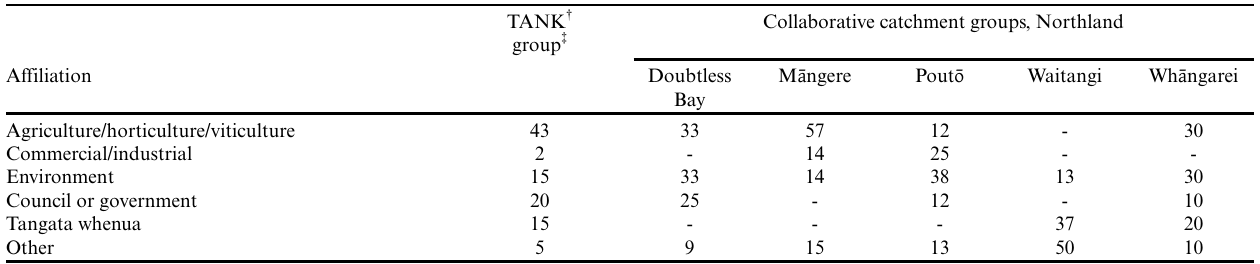
Table 4 . Distribution of respondents by